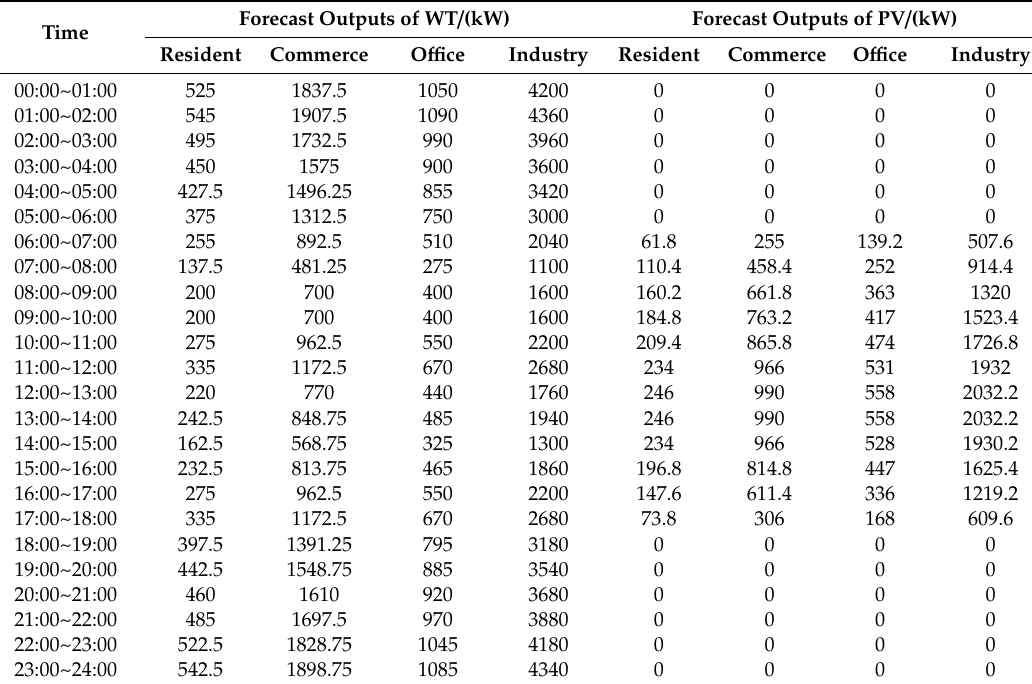
Table A2. Forecast outputs of WT and